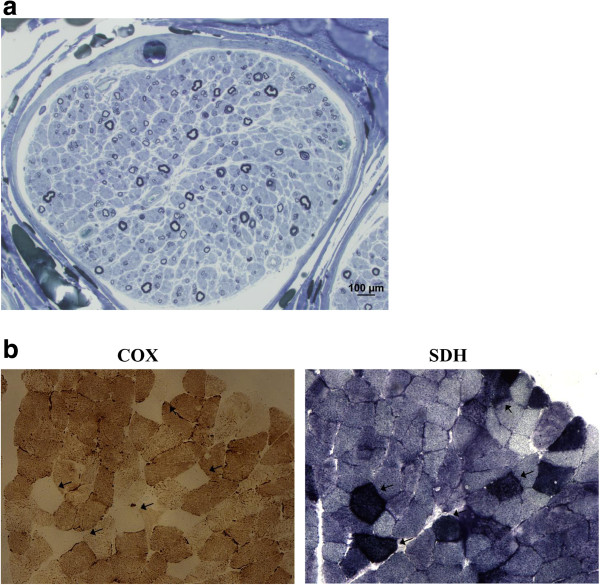
Findings of nerve biopsy (semithin section in blue toluidine) and muscle sections stained for cytochrome c oxidase (COX) and succinate dehydrogenase (SDH) reactions. a: Nerve biopsy shows loss of both small and large nerve fibers. b: Muscle biopsy shows several fibers with absence of COX activity (arrow) and marked mitochondrial proliferation, as shown by their strong SDH reaction.